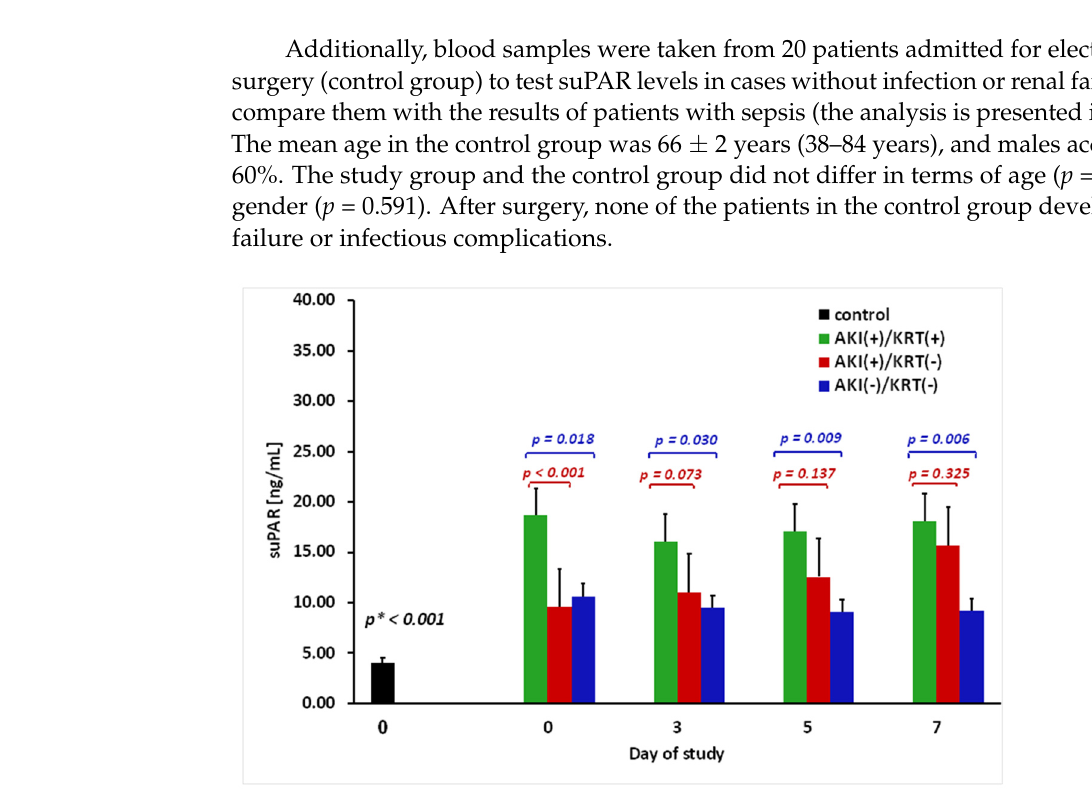
Figure 1. Plasma levels of the suPAR measured on the 0, 3rd, 5th, and 7th day of the study. The p -value represents a significant difference in the suPAR level between the study groups: AKI(+)/KRT(+) and AKI(+)/KRT( − ) and between AKI(+)/KRT(+) and AKI( − )/KRT( − ) calculated on each day of observation using the Kruskal–Wallis test with post hoc analysis. The difference between groups AKI(+)/KRT( − ) and AKI( − )/KRT( − ) was not significant on any of the observation days. The p * value represents the difference in the suPAR level between the control and study group (day 0).